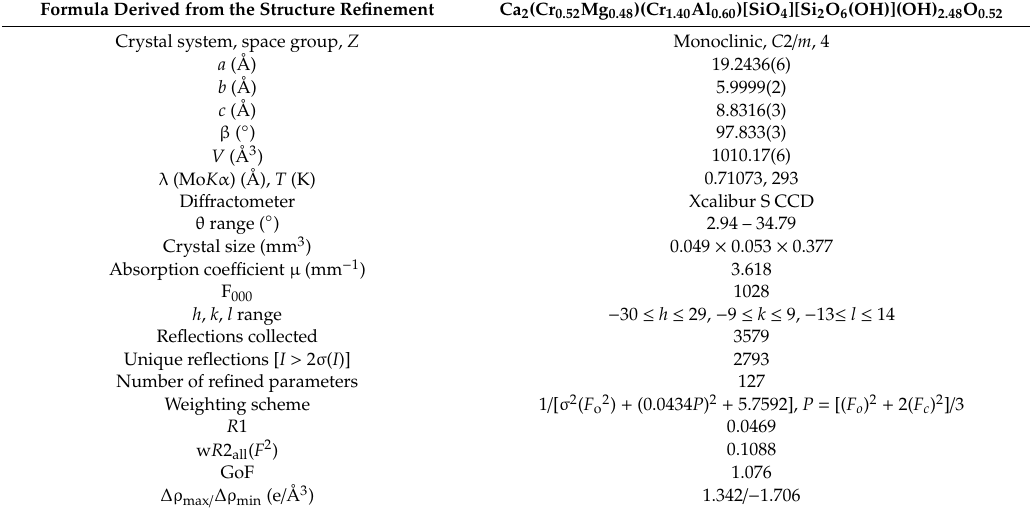
Table 3. Crystal data, data collection information and structure refinement details for shuiskite-(Cr). Formula Derived from the Structure Refinement